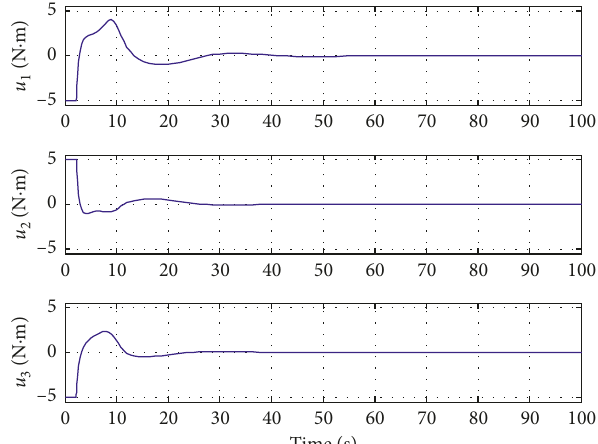
Figure 6: Time response of control input u when Φ � 320 ∘ after